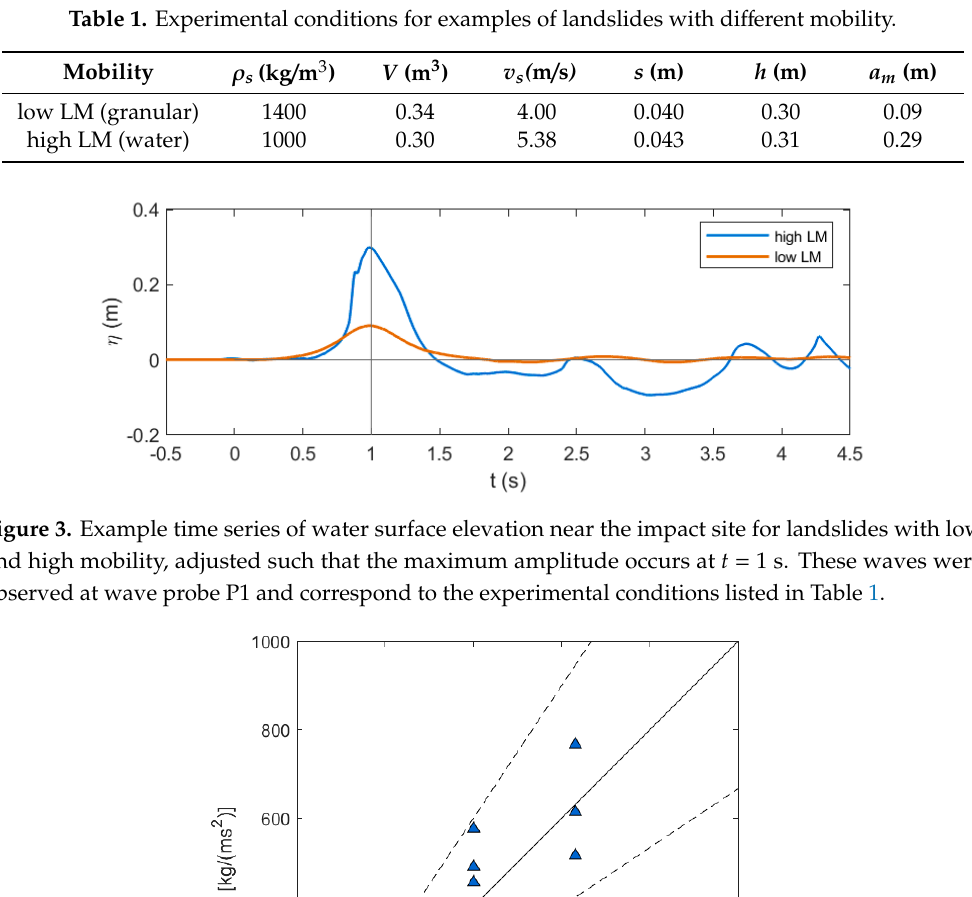
Table 1. Experimental conditions for examples of landslides with different mobility.